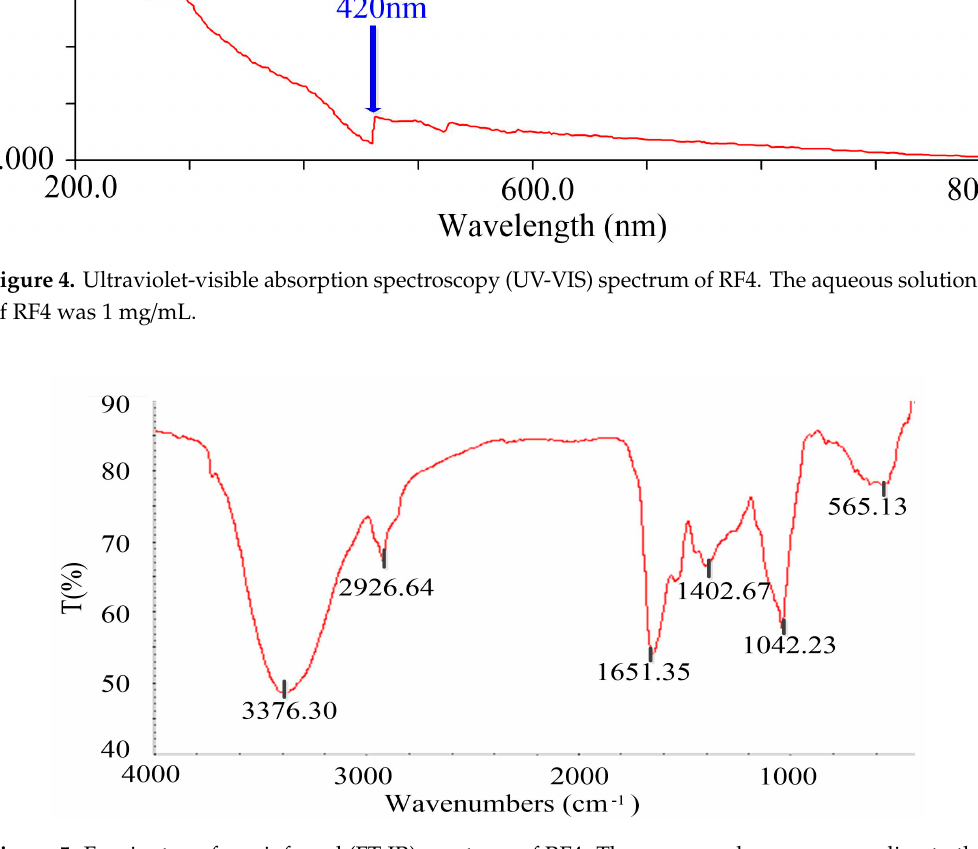
Figure 5. Fourier transform infrared (FT-IR) spectrum of RF4. The wavenumbers corresponding to the important absorption peaks were marked in the figure.